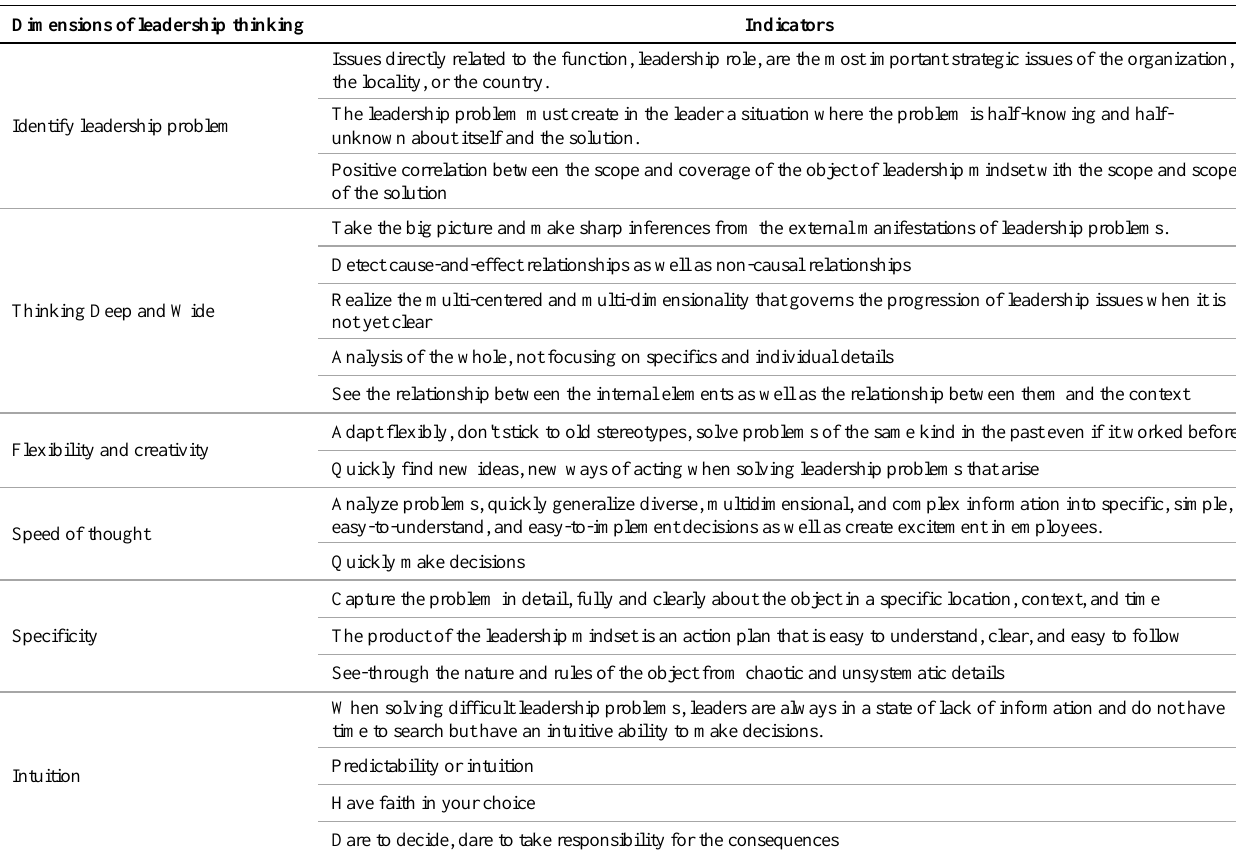
Table 2. Dimensions of leadership thinking